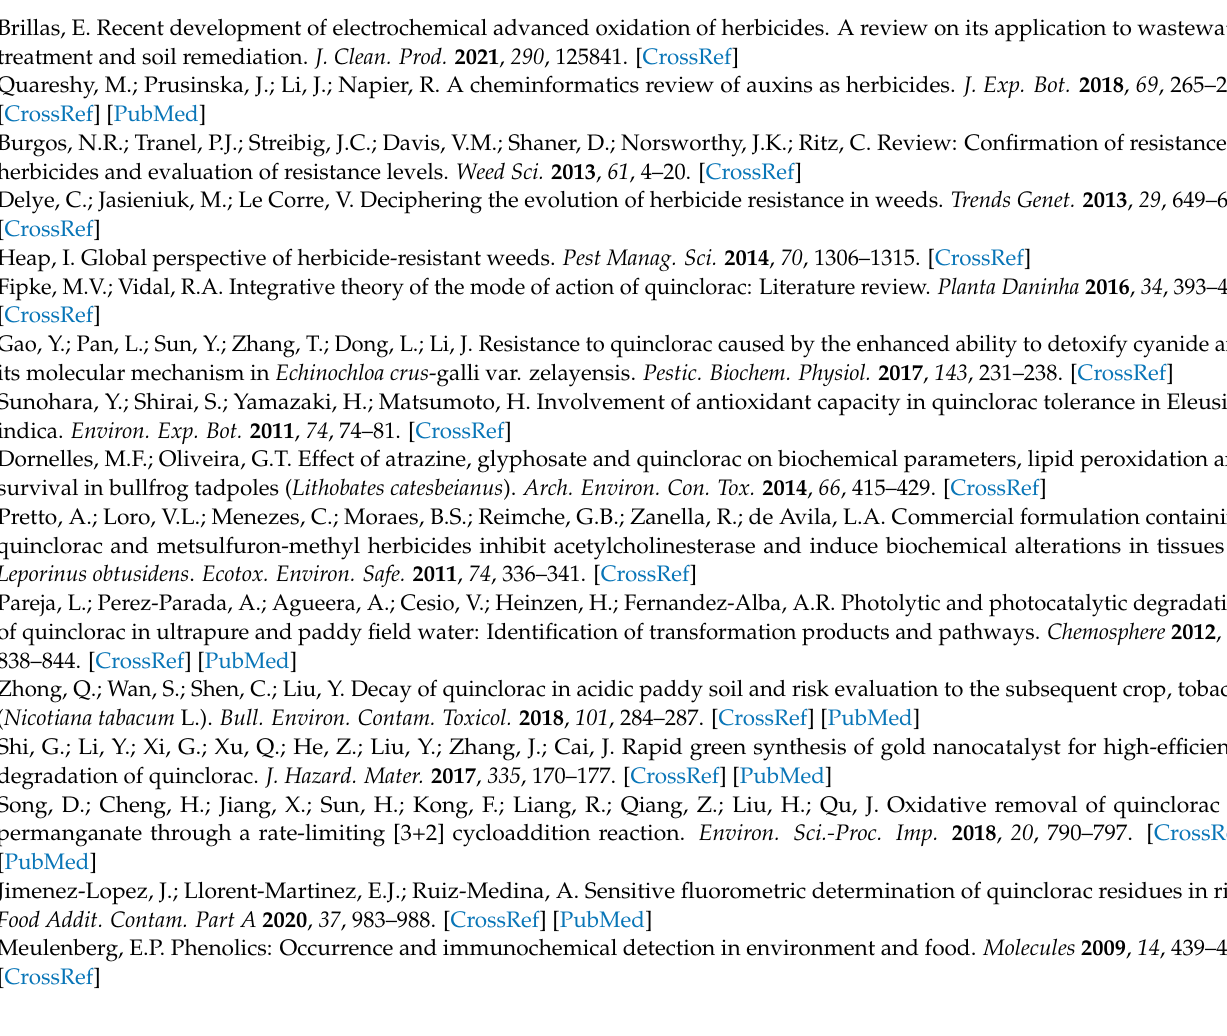
hapten. Figure S2: The UV absorption spectra of hapten, coating antigen, and OVA. Figure S3: The UV absorption spectra of hapten, immunogen, and BSA. Figure S4: The SDS-PAGE of MAb. Table S1: The optimization of ELISA and TRFIA parameters for